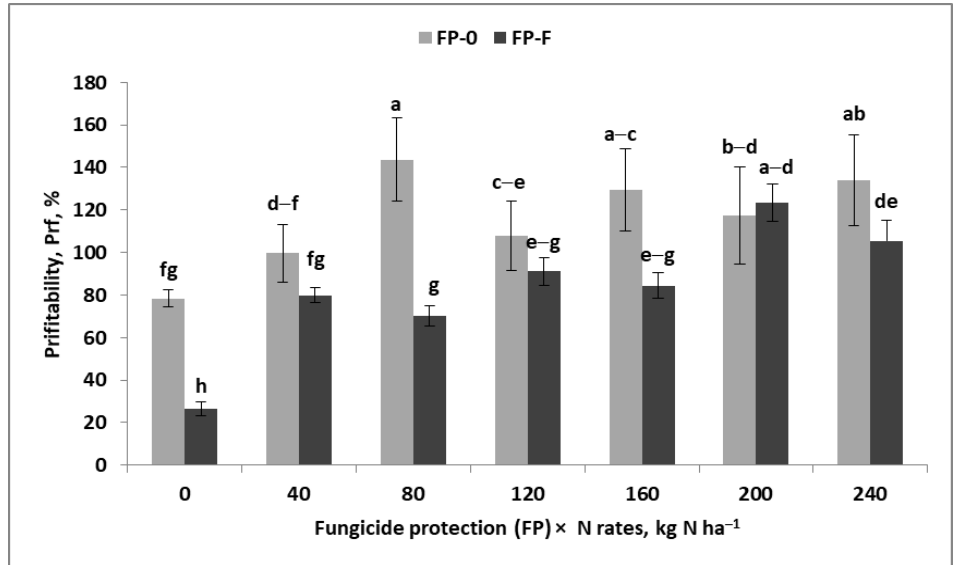
Figure 9. Effect of winter wheat protection with fungicides and rates of fertiliser nitrogen on net profitability of wheat production. Similar letters in the column means a lack of significant differences using Tukey’s test; the vertical bar in the column refers to the standard error of the mean.